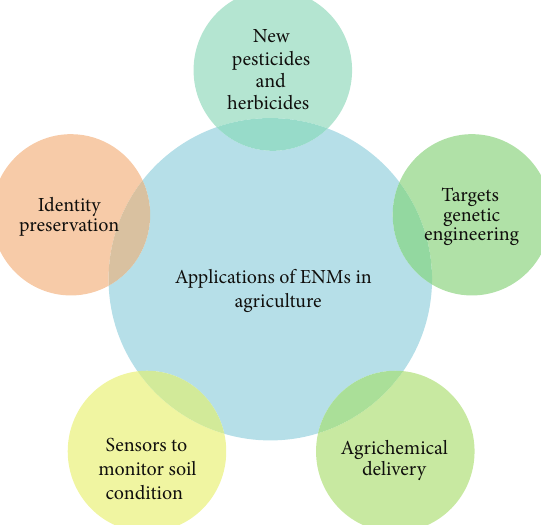
Figure 3: General application of engineered nanomaterials in